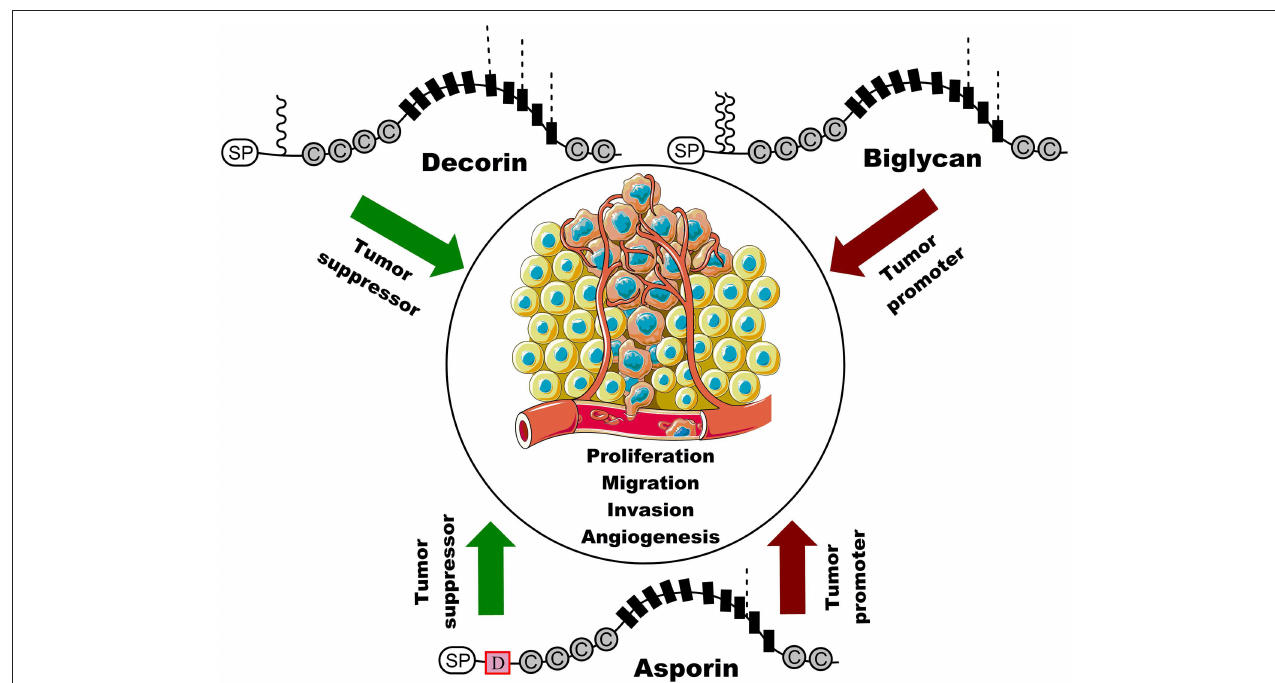
FIGURE 1 | Schematic representation of the structure of three class I SLRP members and their roles in cancer. Decorin suppresses cancer cell proliferation, migration, invasion, and angiogenesis, whereas biglycan is positively associated with cancer cell proliferation, migration, invasion, and angiogenesis. Interestingly, asporin serves as tumor suppressor gene or oncogene in different types of cancer. SP indicates signal peptides and C represents cysteine region. Black boxes indicate a leucine rich repeat (LRR) motif and D represents the unique and conserved aspartic acid (D)-repeats in asporin. Waved line indicates O-linked glycosylation site and dashed line represents N-linked glycosylation. Original elements used in this diagram are from Servier Medical Art